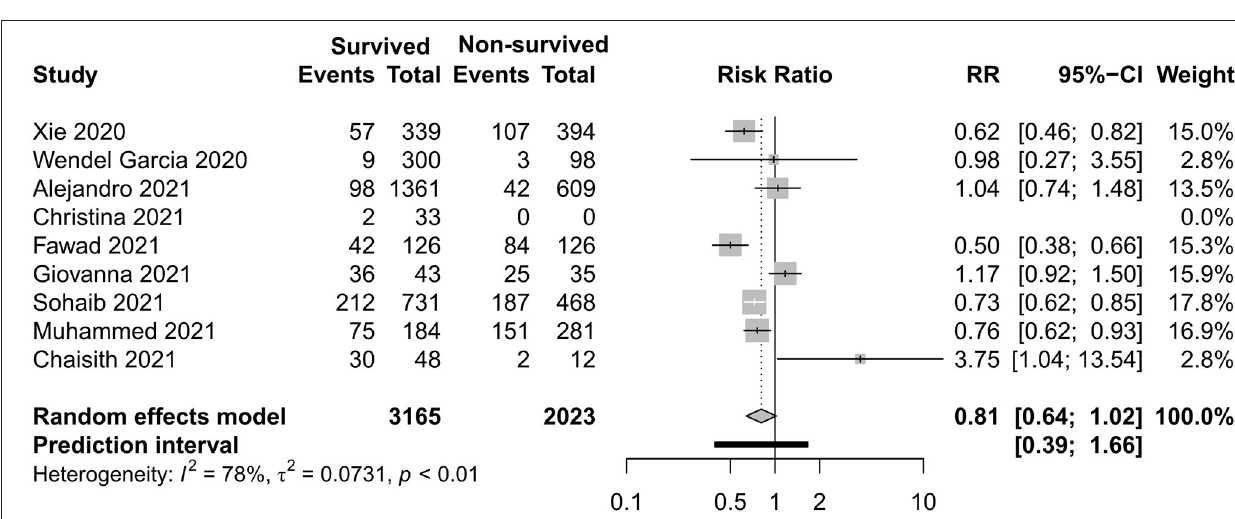
FIGURE 9 | Risk ratio of non-invasive ventilation between survived and non-survived